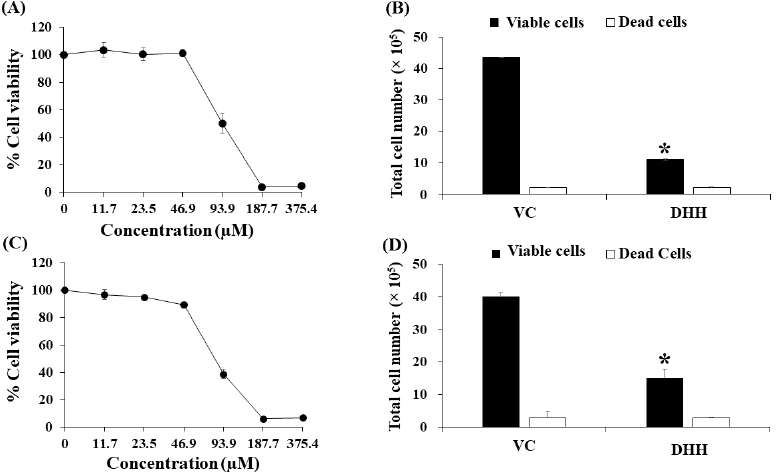
Figure 3. Effects of DHH from C. comosa on the cytotoxicity and total cell number of drug-resistant K562/Dox and drug-sensitive K562 cells. K562/ADR and K562 cells were treated with DHH for 48 h: ( A ) Cytotoxicity of DHH treatment in drug-sensitive K562 cells by MTT assay; ( B ) total number of K562 cells after DHH treatment at IC 20 value (61.2 µM) was determined using the trypan blue exclusion method; ( C ) cytotoxicity of DHH in drug-resistant K562/ADR cells by MTT assay; ( D ) total cell number of K562/ADR cells after DHH treatment at IC 20 value (55.6 µM) was determined using the trypan blue exclusion method. The data are shown as mean ± SD from independent ex- periments performed in triplicate. The significance of mean differences was assessed using one-way ANOVA. * p < 0.05 as compared with vehicle control (VC). 2.2. Effect of DHH on P-gp Protein Expression in K562/ADR Cells Cellular P-gp protein expression and function affect drug accumulation in the cells, which has implications for cancer treatment. The suppression of P-gp expression allows for increased drug accumulation in drug-resistant cells. In this study, P-gp expression was examined after DHH treatments with the IC 20 value (55.6 µM) in K562/ADR cells by West- ern blotting. The results showed no significant decrease in the P-gp expression in the K562/ADR cells at 48 h (Figure 4). Thus, this suggests that DHH did not affect the P-gp expression in K562/ADR cells. However, the demonstration that DHH decreases cell via- bility and proliferation of these cells, prompted us to further explore P-gp function, as we have reported below.